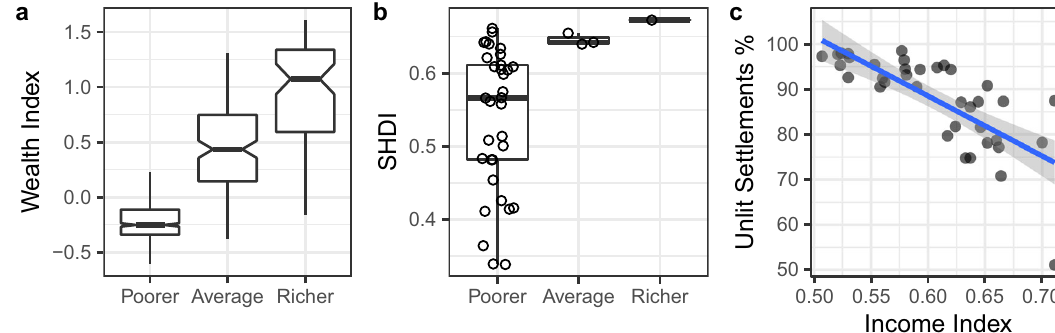
Fig. 4 A spatial comparison of this study ’ s results over Nigeria. a Wealth index produced via deep learning 30 . b The Subnational Human Development Index (SHDI). c The share of unlit settlements predicting the SHDI Income Index. The lower and upper boxplot bounds represent 25th and 75th percentiles, respectively. The lower and upper whiskers represent minima/maxima no further than 1.5 times the interquartile range from the hinge. The notched boxplot represents the 95% con fi dence interval. The gray background indicates 95% con fi dence